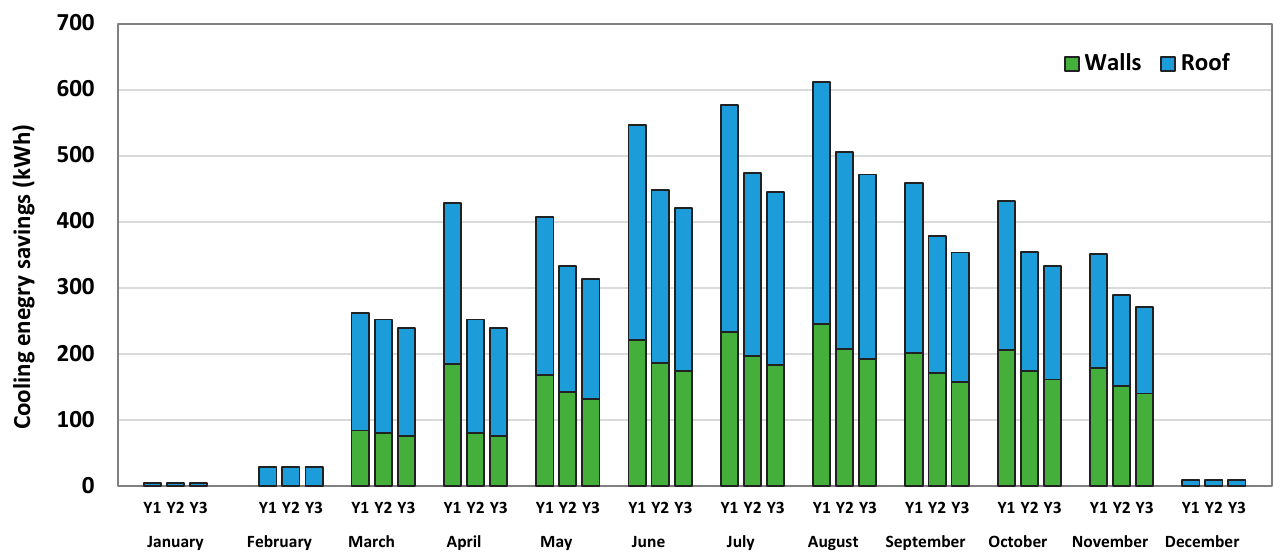
Figure 18. Trends showing the aging effect on cooling energy savings. All the savings reported in this work are compared to the base case ( α r = 0.9, SRI r = 6.6 α w = 0.8, SRI w = 16.7). During the first-year maximum energy savings are observed and declined after that due to a decrease in SRI of the cool surfaces. Total energy savings (walls and roof) of 4115 kWh is estimated using average SRI values in the first year, which are reduced by 16.7% and 6.2% in the second and third years, respectively. For retrofitting with a white roof and light beige wall color, a 30% overall reduction in energy savings (10% in y1, 15% in y2, and 5% in y3) is estimated at the end of three years. This estimation is based on considering annual average changes in SRI values (12.3% in y1, 19% in y2, and 8% in y3 for roofs and 8.2% in y1, 12.6% in y2, and 5.4% in y3 for walls). The results again stress the prominence of accounting for the annual degradation of the radiative properties.